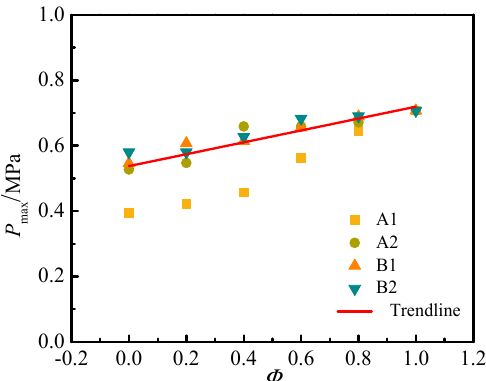
Figure 6. The maximum explosive pressure P max of coal dust and gas mixtures changing with the gas equivalent ratio.